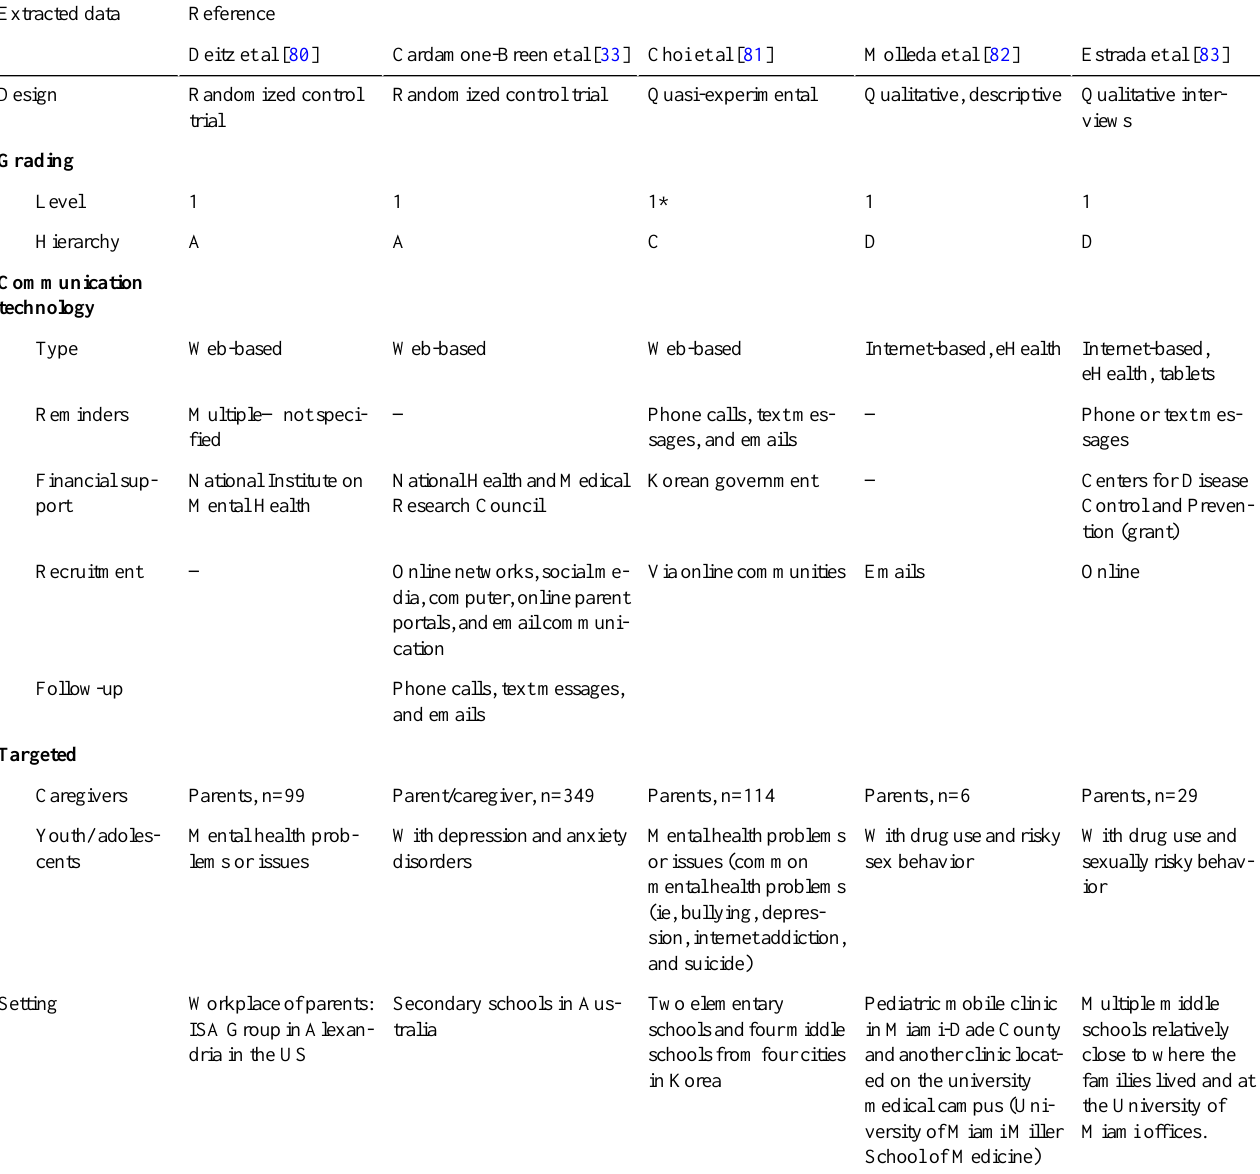
Table 3. Summary of included articles’study